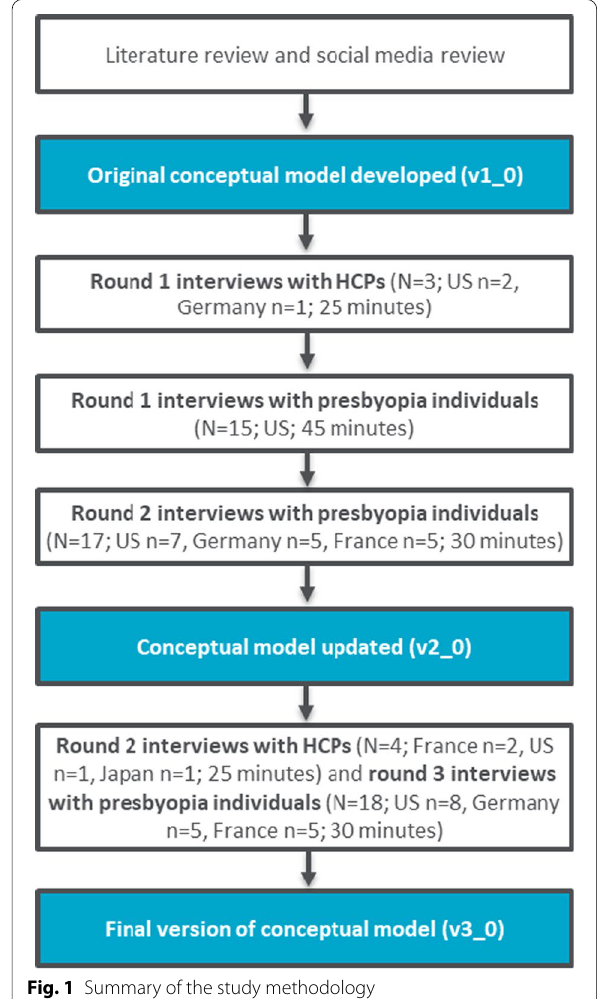
Fig. 1 Summary of the study